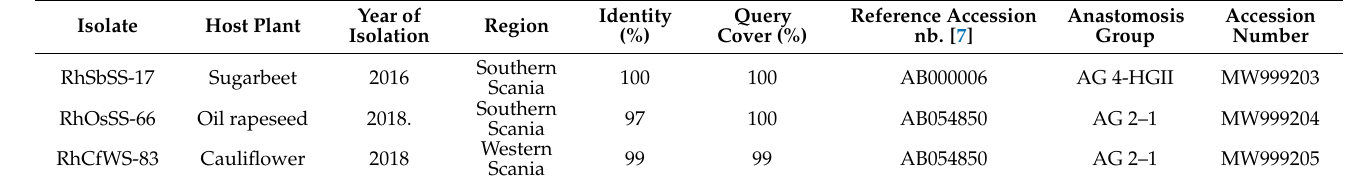
Table 2. Positive control strains sampled from different hosts 1 in different Swedish regions 2